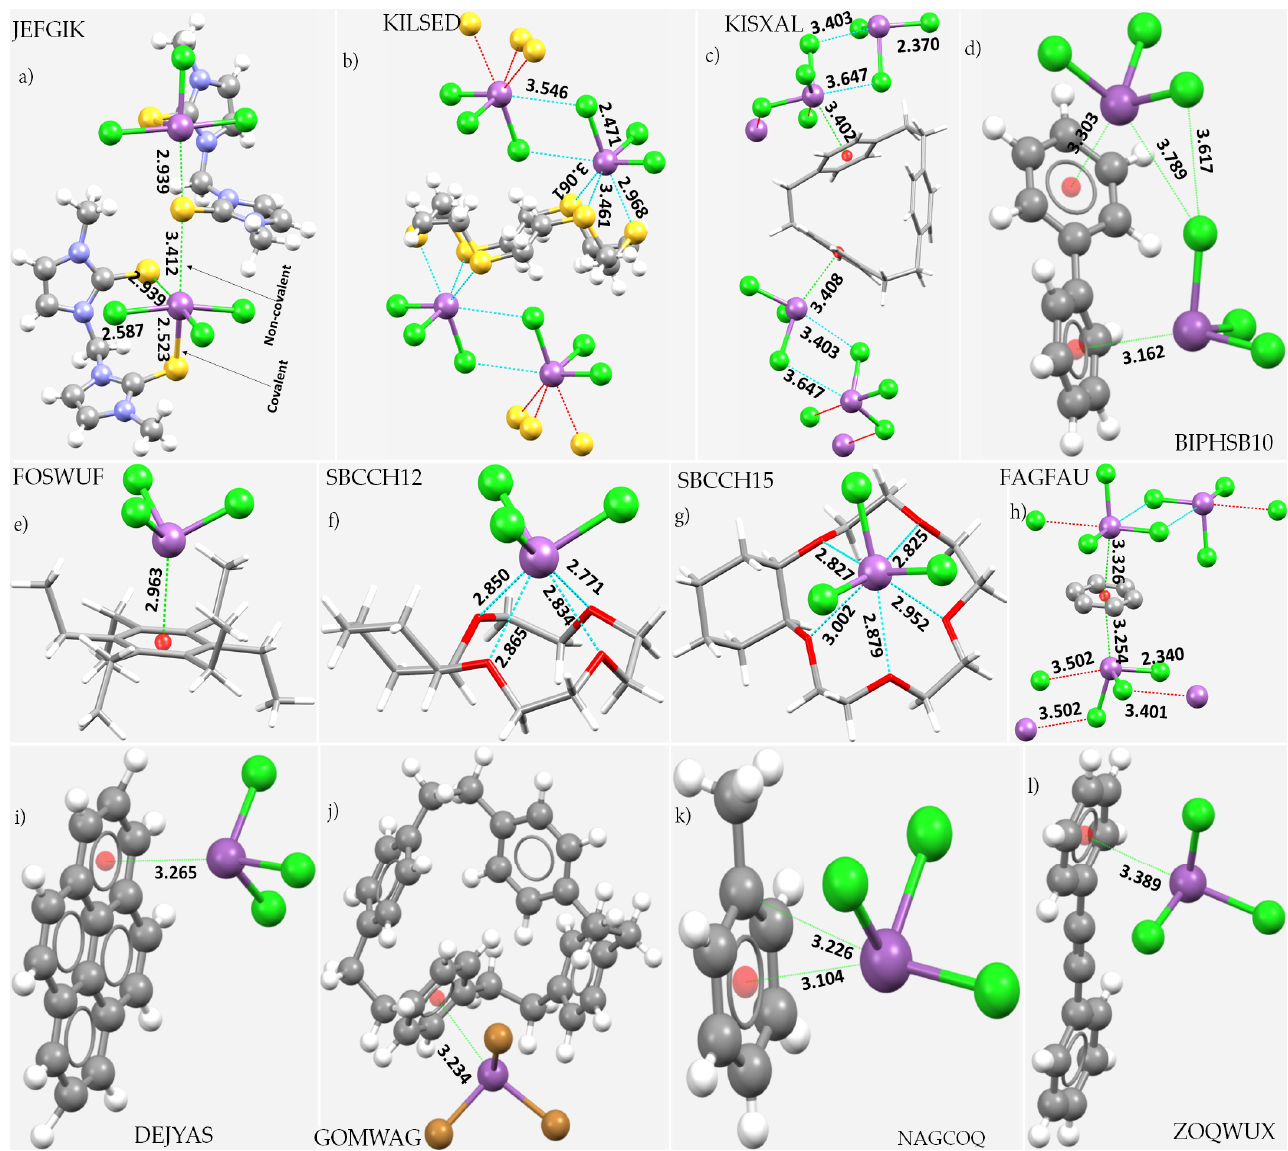
Figure 1. Some selected examples (with CSD codes in capital letters) illustrating the possibility of Sb···X pnictogen bonding interactions formed by covalently bound Sb in SbCl 3 and SbBr 3 upon at- tractive engagement with a variety of interacting molecules containing pnictogen bond acceptors X, where X refers the halogen derivatives, O, S, and π -density. Selected Sb···X intermolecular distances and the Sb–X covalent/coordinate bond distances (in Å) are shown for most cases, indicating clear evidence of the difference in distances between Sb···X and Sb ‒ X. The centroid of the arene moiety (tiny sphere in red) to Sb distances in several cases are also shown in Å. Atom type is shown where appropriate. The compounds are ( a ) SbCl 3 mbit (mbit = bidentate 1,1’-methylene-bis(3-methyl-2H-imidazole-2-thione) [108]; ( b ) SbCl 3 .18S 6 (18S 6 = the crown ether 1,4,7,10,13,16-hexathiacyclooctadecane) [109]; ( c ) (C 24 H 24 )(SbCl 3 ) 2 (C 24 H 24 = [2.2.2]paracy- clophane) [110]; ( d ) biphenyl bis(antimony trichloride) [111]; ( e ) (C 18 H 30 )SbCl 3 (C 18 H 30 = hex- aethylbenzene) [112]; ( f ) (cyclohexo-12-crown-4)SbCl 3 [113]; ( g ) (cyclohexo-15-crown-5)SbCl 3 [114]; ( h ) (benzene)(SbCl 3 ) 2 [115]; ( i ) pyrene bis(trichloro-antimony) [116]; ( j ) [2.2.2.2]-Paracyclophane tribromo-antimony [117]; ( k ) trichloro-antimony toluene [118]; ( l ) tetrakis(trichloro-antimony) 1,2- diphenylethyne